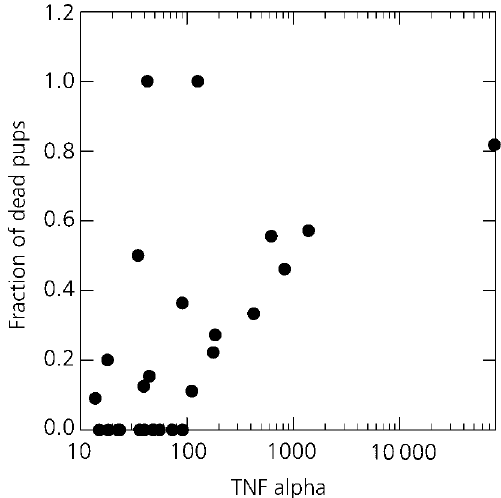
Figure 1 Fraction of dead pups against TNF- a